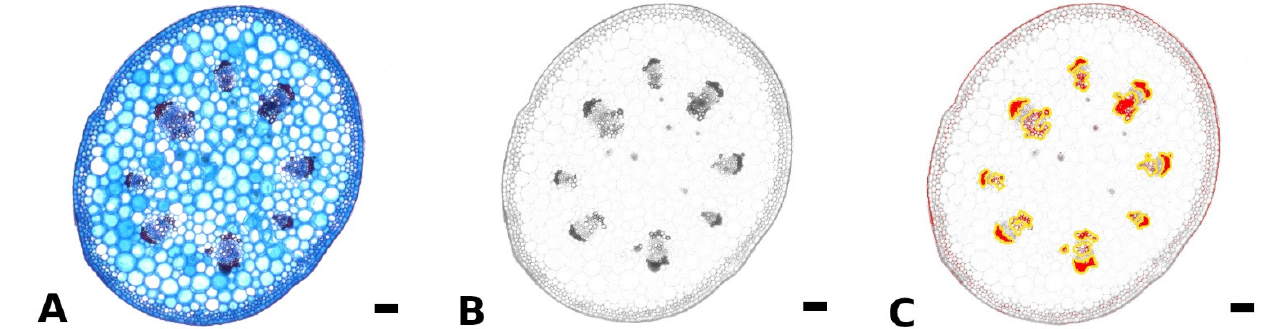
Figure 5. Method for measurement of lignified petiole tissue using ImageJ. The original colored image of a petiole cross section of Begonia amphioxus ( A ) was split into RGB channels, and only the blue channel (where lignified tissue appears dark) was used for further analysis ( B ). Via the threshold function, the lignified tissue was highlighted (red) and subsequently, added to Regions of Interest (yellow outline), edited and measured ( C ). Scale: 100 µm.